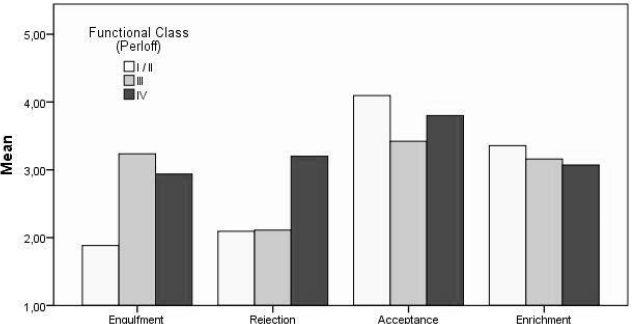
Figure 3. Mean Differences in Illness Identity by Perloff’s Functional Classification [24]. Figure 3. Mean Di ff erences in Illness Identity by Perlo ff ’s Functional Classification